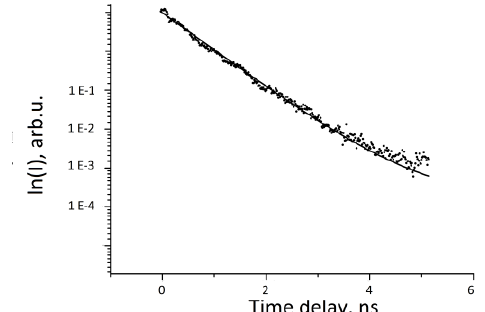
Fig. 2. Pump probe signal for a Ge:As sample at the wave- length was λ = 131.2